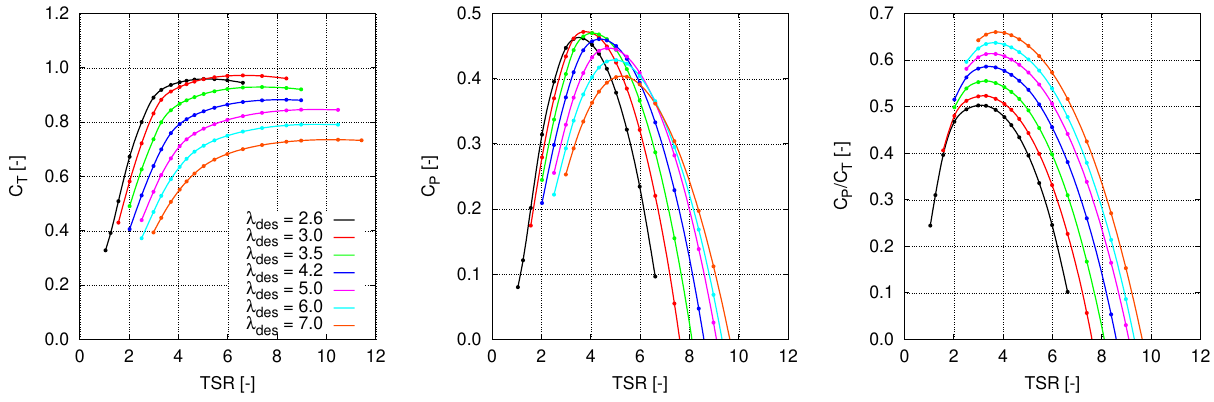
/C for λ des values from 2.6 to 7.0. P T